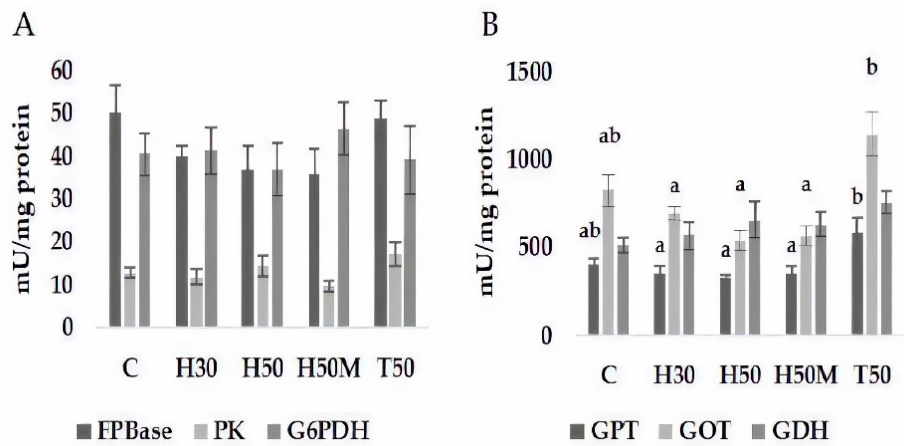
Figure 1. Enzymes of intermediary metabolism of Sparus aurata fed with experimental diets. Means ( ± SE) of three replicate tanks (30 fish/tank). Different letters indicate significant differences ( p < 0.05) based on Tukey–Kramer HSD tests. Columns without letters indicate an absence of significant differences. Sugar-related enzymes are depicted in Subfigure ( A ) (FPBase (fructose-1,6-biphosphatase); PK (pyruvate kinase); G6PDH (glucose-6-phosphate dehydrogenase)) and amino acid-related enzymes in Subfigure ( B ) (GPT (glutamate pyruvate transaminase); GOT (glutamic oxalacetic transaminase); GDH (glutamate dehydrogenase)).